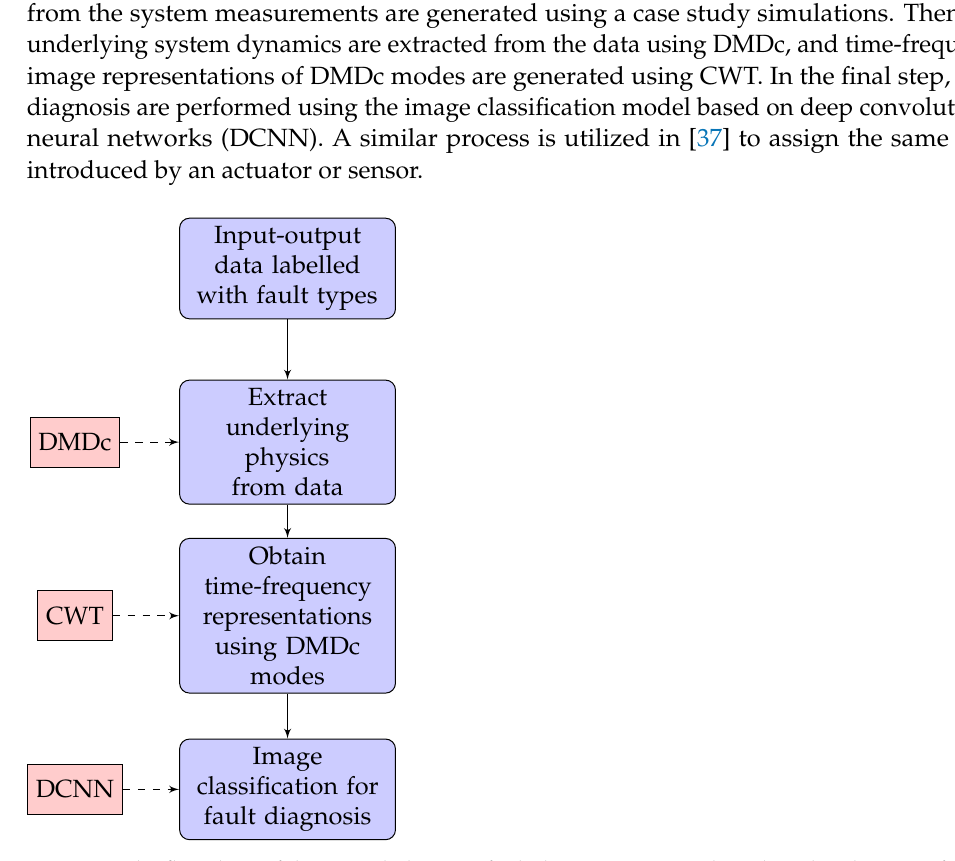
Figure 1. The flowchart of the extended sensor fault diagnosis process based on the physics-informed transfer learning framework proposed in